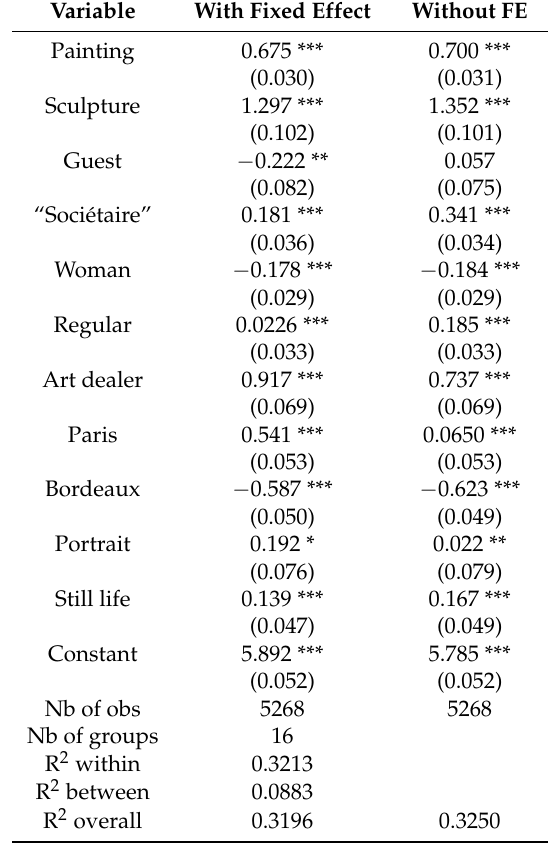
Table A1. Hedonic regression of the price of the artworks exhibited at the SAIB, in constant 1928 francs, expressed in logarithm.